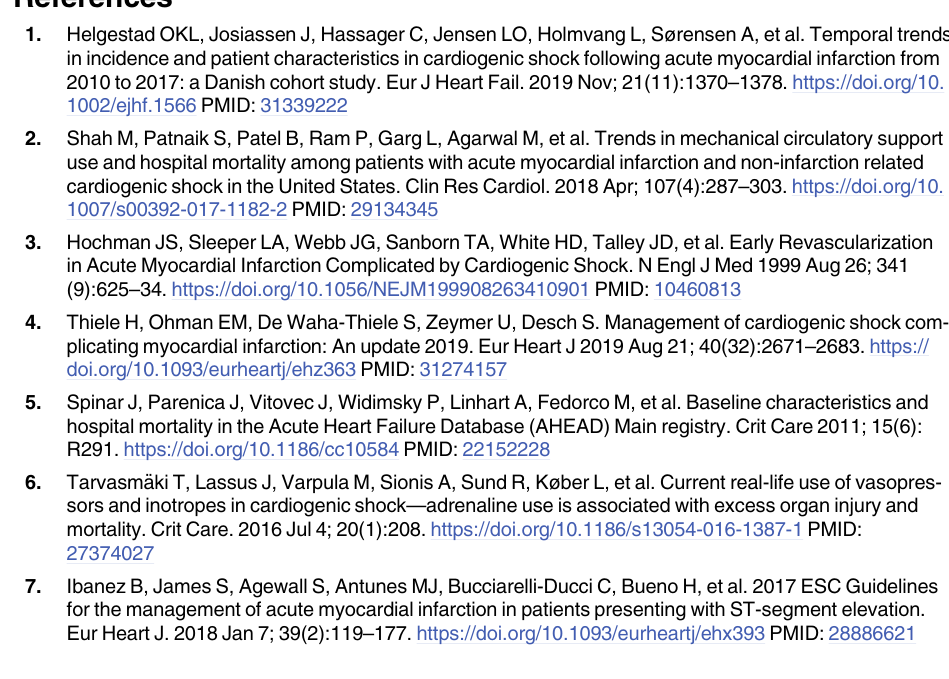
S2 Table. Patient characteristics based on the vasoactive strategy within each SCAI group. S3 Table. Cause of death in each SCAI